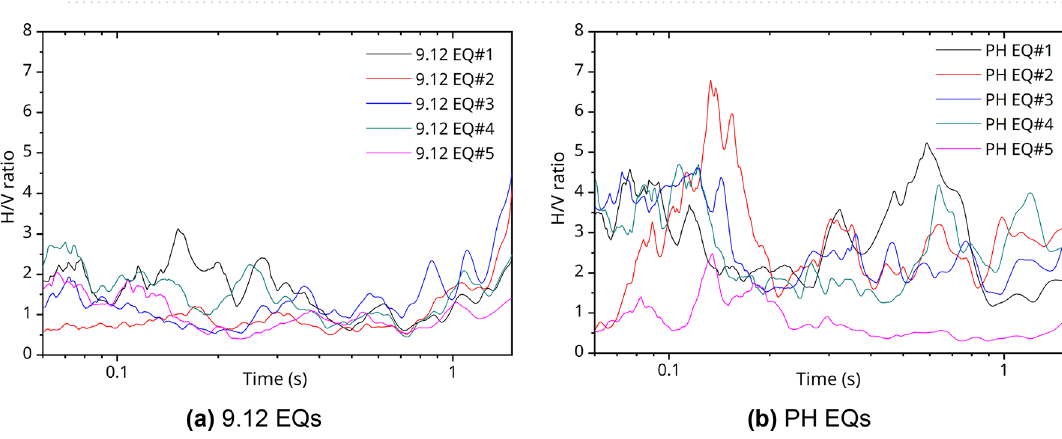
Figure 11. H/V response spectral ratio of Method 2 at